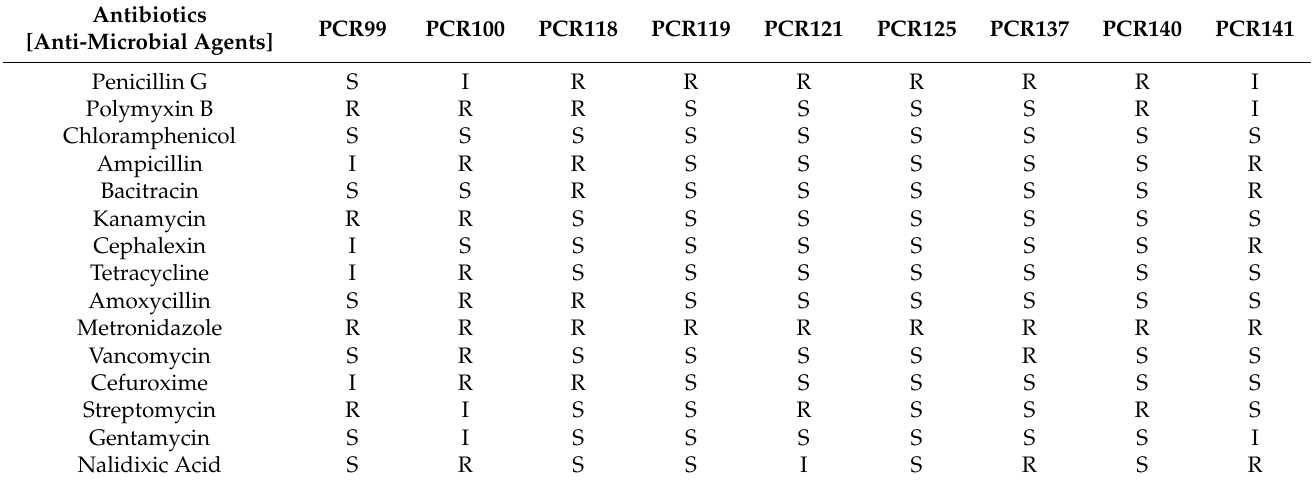
Table 2. Antibiotic Susceptibility Determination of Isolated Lactobacillus strains according to VET- LAB standards.